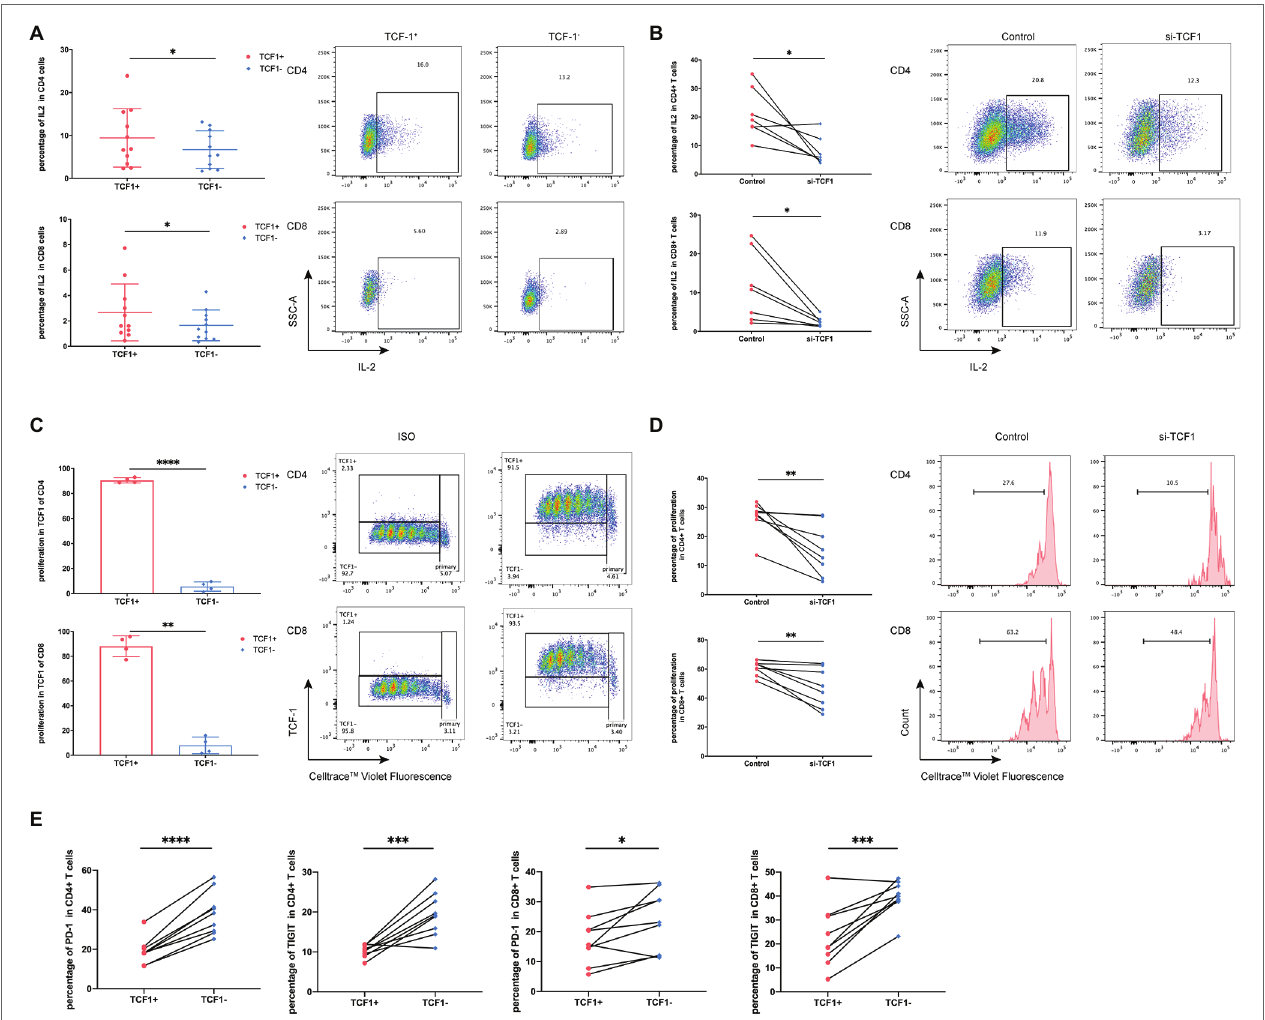
FIGURE 3 | Downregulation of T cell factor (TCF)1 impairs T cell proliferation. (A) To investigate whether TCF1 affects T cell function, primary CD3 + T cells ( n = 11) were stimulated with anti- α CD3/CD28 Dynabeads for 24 h, and GolgiStop (1 μ l/ml) was added to the culture for the final 6 h. Interleukin (IL)2 expression in TCF1 + T cells was compared with TCF1 − T cells. (B) After 24 h transfection with siTCF1, primary T cells ( n = 7) were stimulated using anti- α CD3/CD28 Dynabeads for 24 h and intracellular expression of IL2 was determined. (C) Primary CD3 + T cells ( n = 4) were labeled with Cell Trace ™ Violet and stimulated using anti- α CD3/CD28 Dynabeads for 72 h. The proliferation of TCF1 + CD4 + and TCF1 + CD8 + T cells increased significantly compared with TCF1 − CD4 + and TCF1 − CD8 + T cells. (D) After knockdown with siTCF1 for 24 h, primary CD3 + T cells ( n = 8) were labeled with Cell Trace ™ Violet and stimulated using anti- α CD3/CD28 Dynabeads for 72 h. The proliferation of CD4 + and CD8 + T cells decreased significantly in the absence of TCF1 expression. (E) PD-1 and TIGIT expression in TCF1 + T cells was compared with TCF1 − T cells ( n = 9). Paired t -tests were used for analysis. * p < 0.05, ** p < 0.01, *** p <